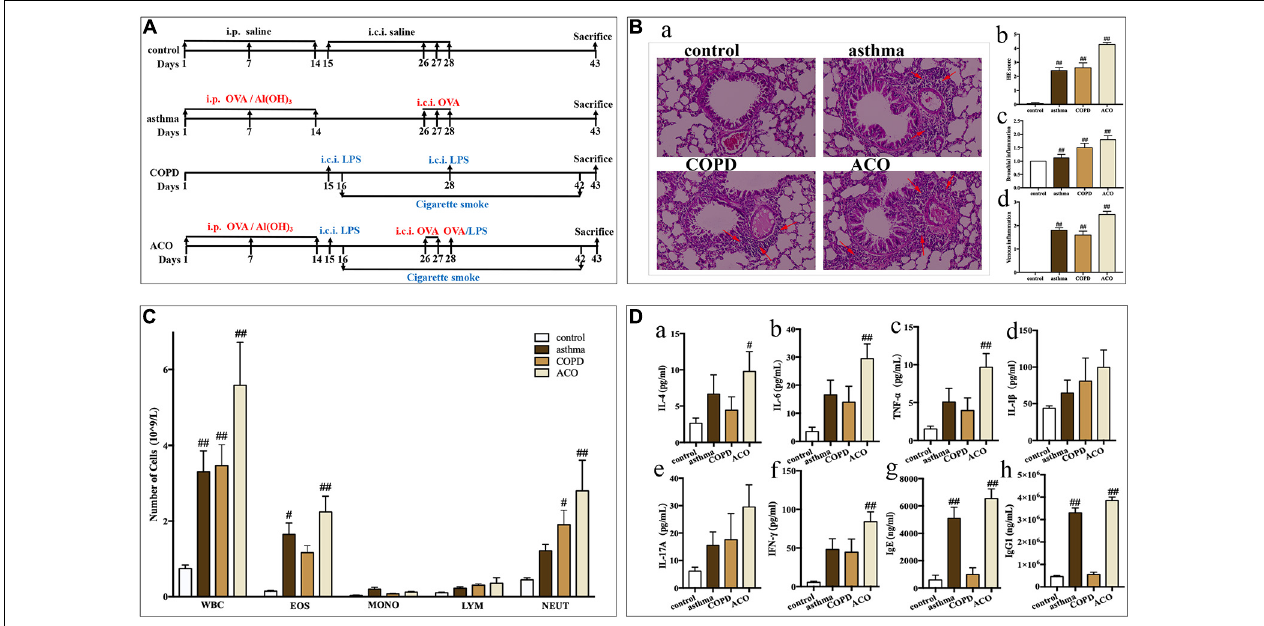
FIGURE 1 | Validation of mouse ACO model. (A) timeline of the animal experimental protocol. (B) (a) : hematoxylin-eosin staining of lung tissue (magnified × 100) and its scores of inflammatory cells infiltration, (b) : total infiltrating scores, (c) : bronchial infiltrating scores, (d) : venous infiltrating scores ( n = 15 independent slices from three mice of each group have been used); arrow shows inflammatory cell infiltration. (C) total and differential leukocyte counts in BALF ( n = 5). (D) the level of IL-4 (a) , IL-6 (b) , TNF- α (c) , IL-1 β (d) , IL-17A (e) , and IFN- γ (f) in BALF ( n = 5) and the level of IgE (g) and IgG1 (h) in serum ( n = 6). Data were shown as mean ± SEM; # P < 0.05 and ## P < 0.01 compared with the control